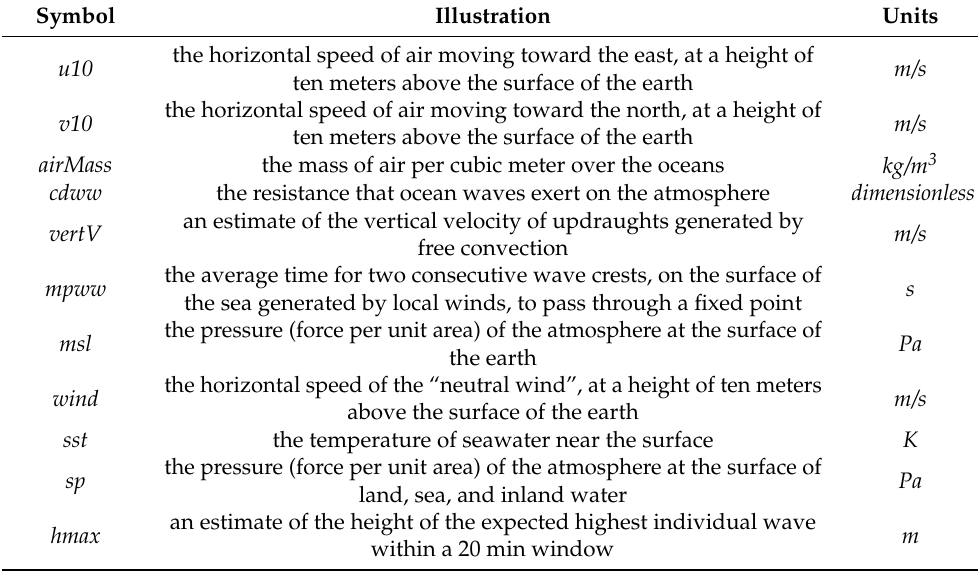
Table 1. Explanations of abbreviated symbols.